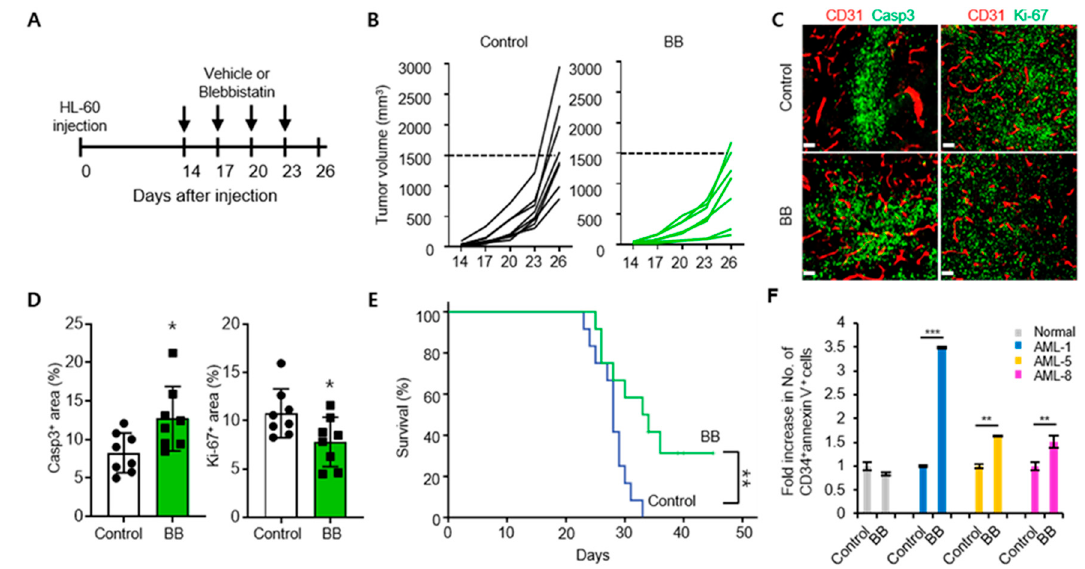
Figure 4. Blebbistatin treatment delays leukemia progression through enhanced apoptosis. ( A ) Mice were subcutaneously implanted with 2 × 10 6 HL-60 cells and treated with intraperitoneal injections of control (vehicle) or blebbistatin (BB, 2 mg/kg). Diagram depicting treatment schedule. Arrows indicate treatment. ( B ) Comparison of HL-60 tumor growth ( n = 8 per group). ( C , D )